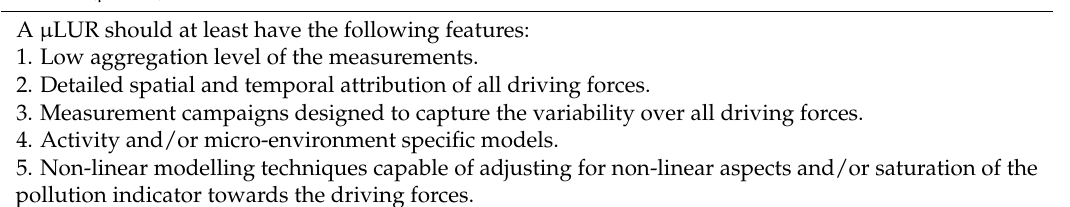
Table 1. Overview of the features of the microscopic Land Use Regression ( µ LUR) methodology. The Microscopic and Micro-Environment Specific Non-Linear Spatiotemporal Land-Use Regression